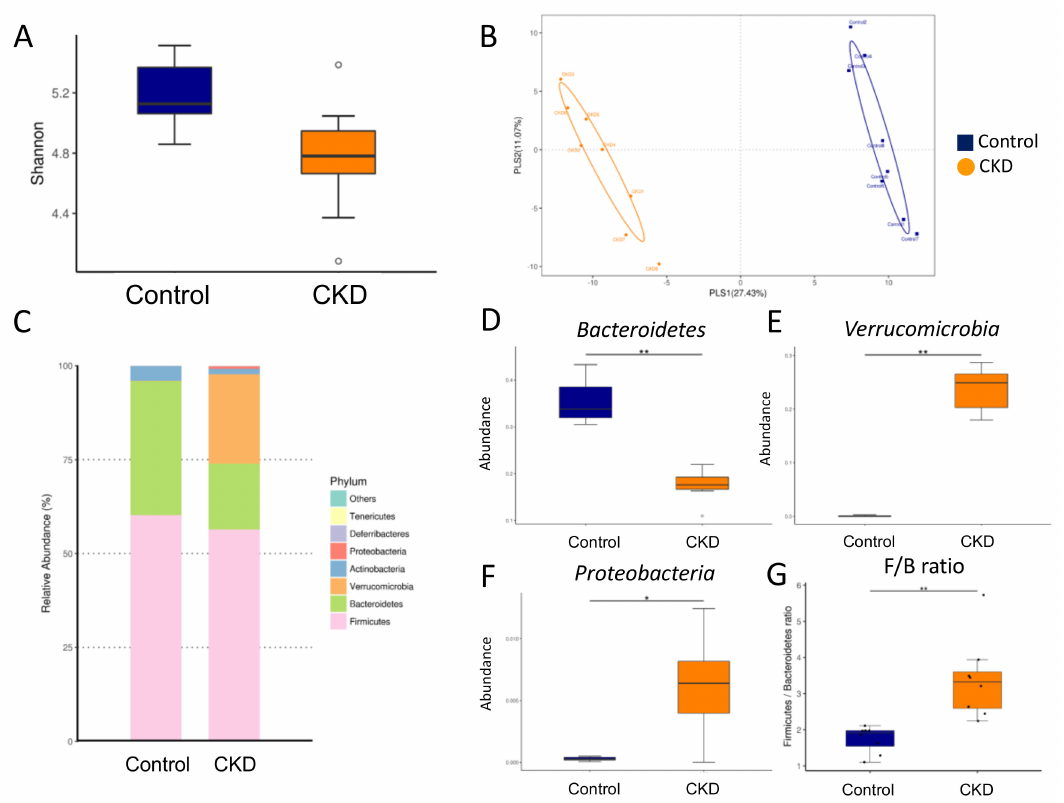
Figure 3. Gut microbiota at the phylum level in mother rats. ( A ) Variation in fecal bacterial α -diversity represented by the Shannon’s diversity indexes, ( B ) β -diversity changes in gut microbiota between the two groups by the partial least squares discriminant analysis (PLS-DA), ( C ) relative abundance of top 10 phyla of the gut microbiota between the two groups. The abundance of phyla ( D ) Bacteroidetes , ( E ) Verrucomicrobia , and ( F ) Patescibacteria between the two groups. ( G ) The Firmicutes to Bacteroidetes ratio between the two groups. Control = female rats fed with regular chow; CKD = female rats fed with chow supplemented with 0.5% adenine for 3 weeks before pregnancy. Abundance = the number of bacterial operational taxonomic unit (OTU) sequences detected in each sample. Data are shown as means ± SD; n = 8 / group. The asterisk indicates p < 0.05 vs. control. The double asterisk indicates p < 0.01 vs.